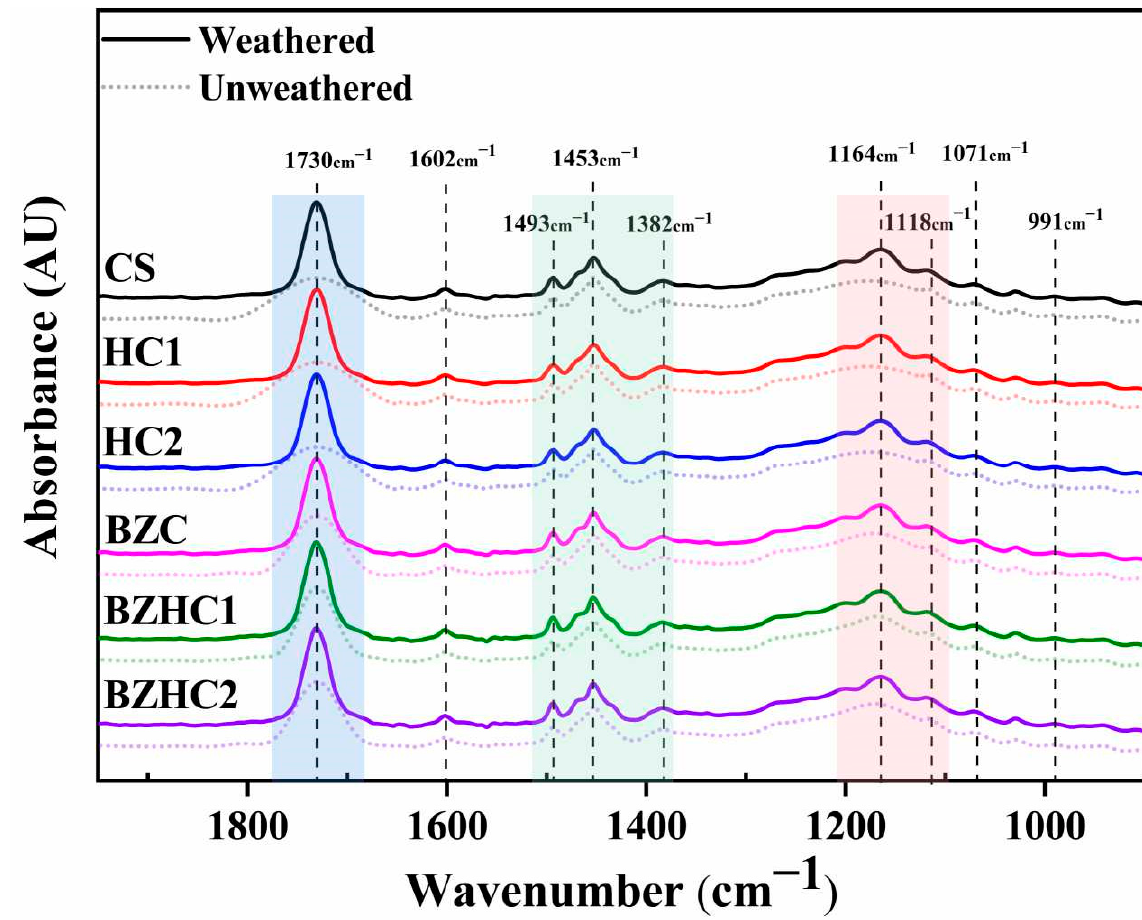
Figure 6. FTIR-ATR spectra of unweathered and weathered samples. Table 3. Relative intensities of the FT-IR absorption peaks of samples.